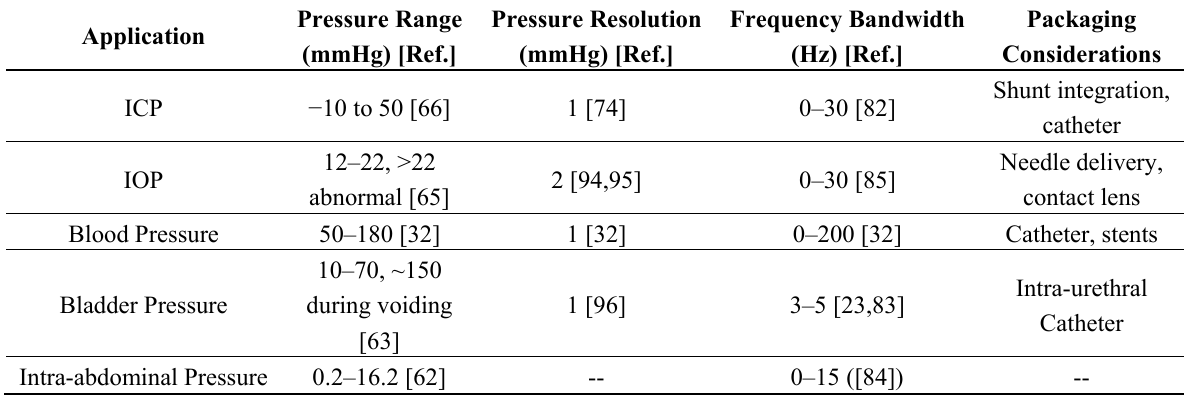
Table 1. Table of relevant parameters in the development of pressure sensors for implantable